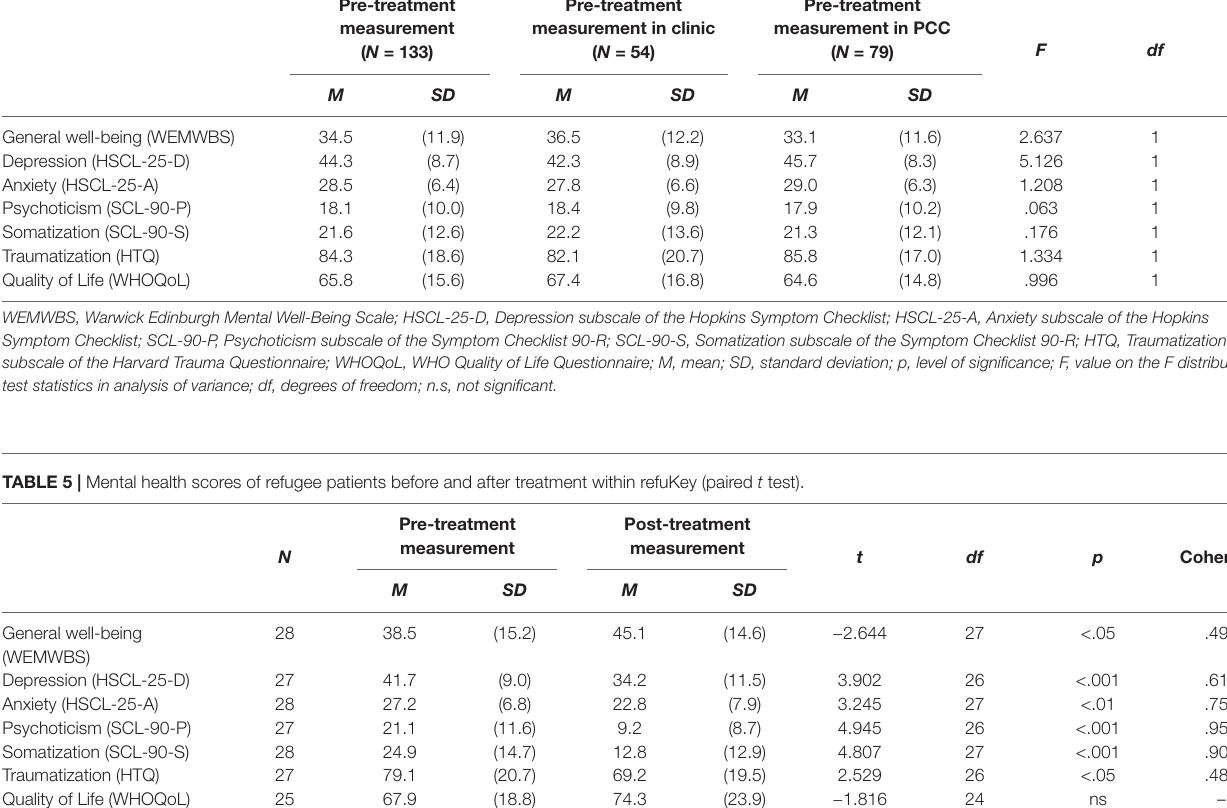
Pre-treatment Pre-treatment measurement measurement in clinic